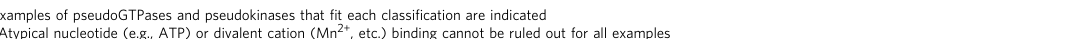
Examples of pseudoGTPases and pseudokinases that fi t each classi fi cation are indicated a Atypical nucleotide (e.g., ATP) or divalent cation (Mn 2+ , etc.) binding cannot be ruled out for all